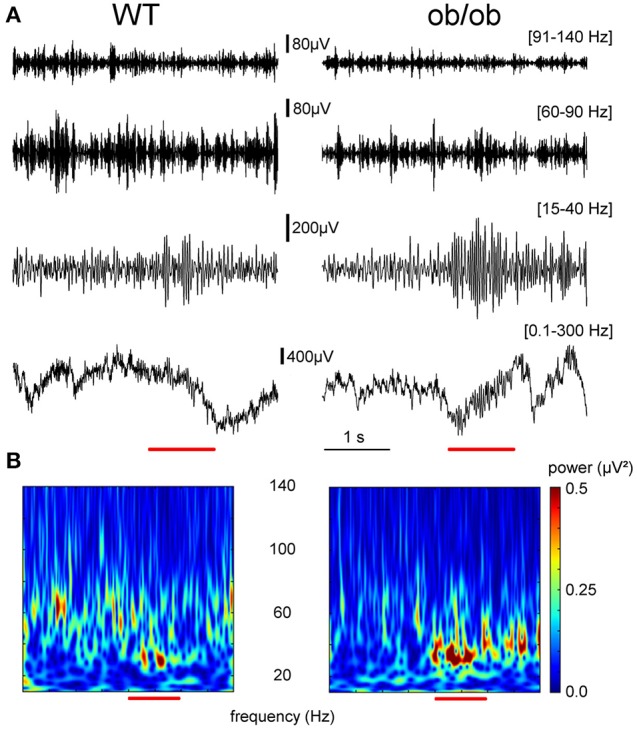
Representative example of LFP signal recorded in WT and ob/ob mice in the OB at the criterion level. (A) Representative example of single trials LFPs recorded in the OB during odor processing (red bar) for a WT (left) and an ob/ob mouse (right). Raw LFP (0.1–300 Hz) and the corresponding filtered signals in the frequency bands of interest in this study (beta 15–40 Hz; gamma 60–90 and 91–140 Hz). The amplitude increase in the beta band was much stronger in the ob/ob mouse compared to the WT. (B) Time-frequency decomposition between 5 and 140 Hz showing that odor sampling transiently changed beta oscillations (15–40 Hz). Odor was butanal. x-Axis, time (in s); y-axis, frequency from 5 to 140 Hz from bottom to top. The color scale represented signal power (μV2). The same scale was used for the 2 mice.